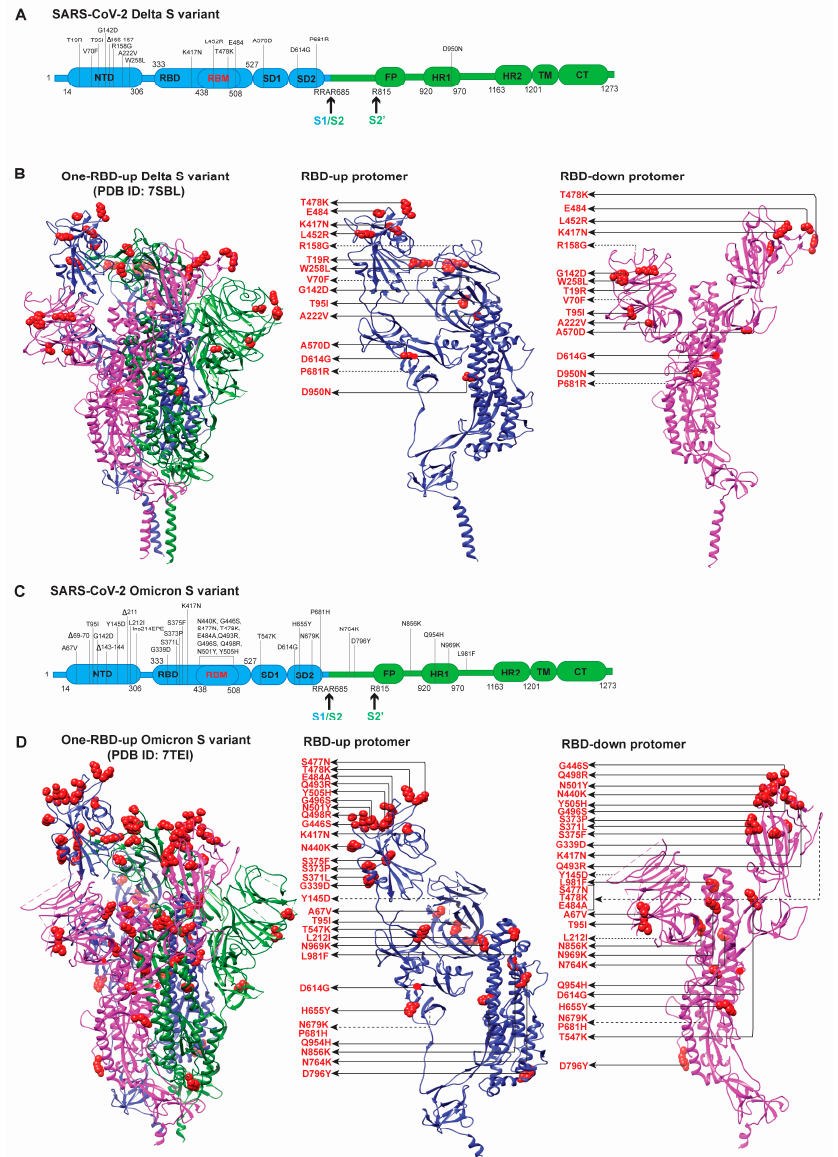
Figure 4. Accumulated mutations in the S Delta and Omicron variants. ( A , B ) Amino acid substitu- tions are shown in the S domains ( A ) and depicted in the one-RBD-up structure ( B ) of the S Delta variant (PDB ID 7SBL). Mutated amino acid residues are highlighted in the RBD-up and RBD-down protomers. The dotted lines indicate the mutated amino acid residues which are not resolved in the structure. ( C , D ) Illustrations as in ( A , B ), respectively, for the S Omicron variant (PDB ID